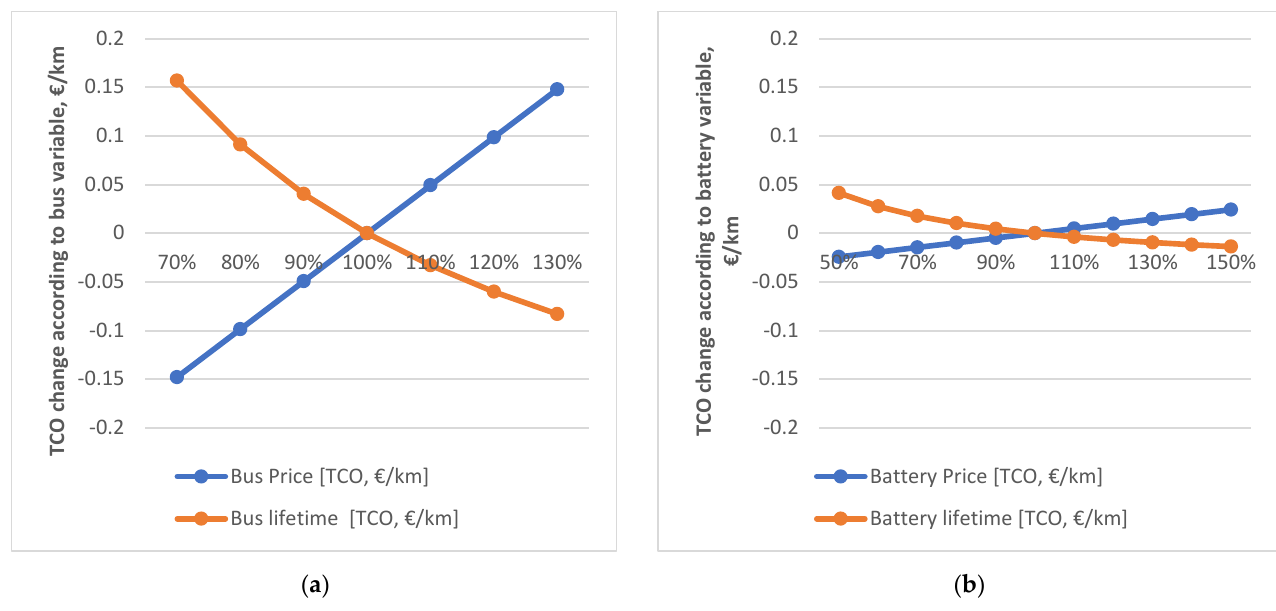
Figure 15. Sensitivity analysis in 2030 results: ( a ) vehicle body price and lifetime of e-buses; ( b ) battery prices and lifetime.